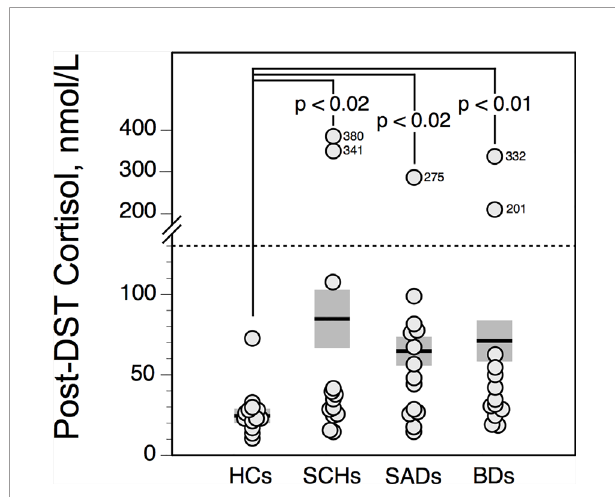
FIGURE 4 | Highest serum cortisol value following dexamethasone suppression test (DST) in controls and patients. The solid horizontal lines indicate the group mean; the shaded areas represent ± SEM. HCs, healthy control subjects; SCHs, patients with paranoid schizophrenia; SADs, patients with schizoaffective disorder; BDs, patients with bipolar